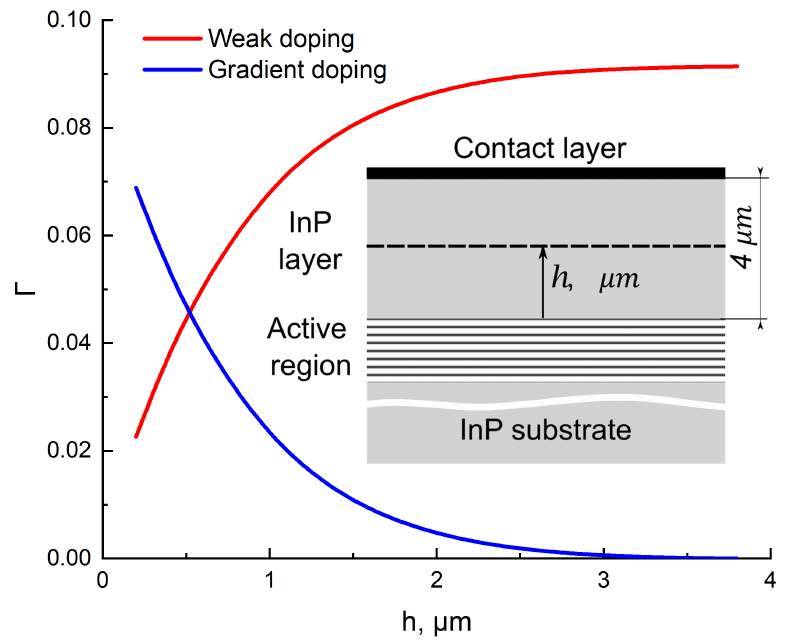
Figure 1. The optical confinement factor Γ in the InP waveguide layers as a function of the distance from the active region. The red curve indicates the weakly doped InP layer, and the blue curve corresponds to a gradient doping varying from 1 × 10 16 to 1 × 10 19 cm − 3 . The inset schematically illustrates the structure: h indicates the distance from the active region and, simultaneously, the thickness of the weakly doped region of the InP